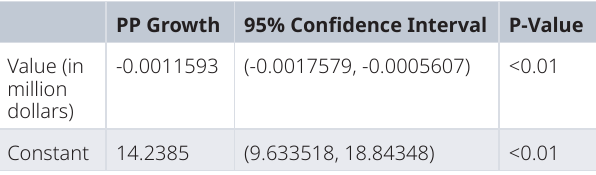
Table 4. Estimating the impact of sin taxes on sales volume of soft drinks in Saudi Arabia using regression